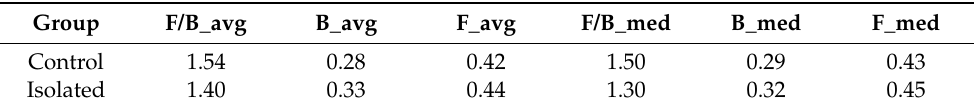
Table 4. Firmicutes to Bacteroides (F/B) ratio between control and isolated group and p -value of difference ( p -value =